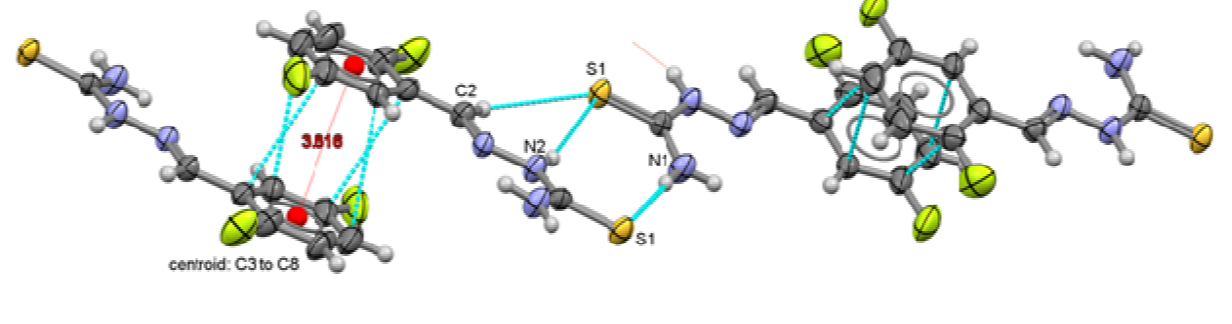
Figure 8. Packing arrangement of 2,5-C interactions between thiophenolate